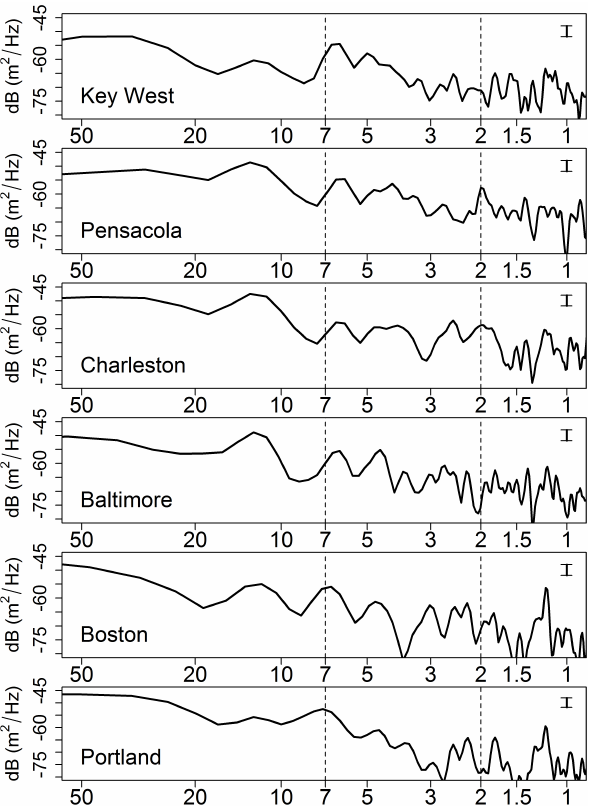
Fig. 7. Power spectral density estimates of interannual sea level variations at six long-term tidal stations along the east coast of the United States. The horizontal axis is the spectral period in years. Vertical dashed lines mark ENSO band frequencies, vertical bar quantifies the 95% confidence interval.